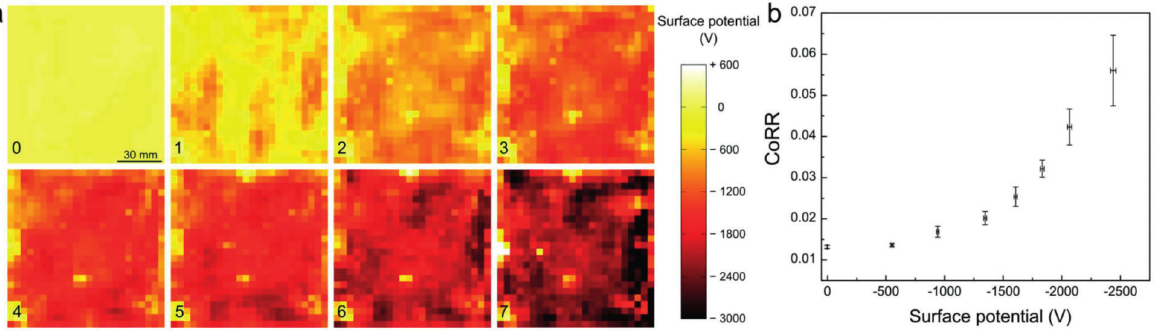
Figure 9 - ( a ) Potential maps of PTFe plates tribocharged by friction with polyethylene. ( b ) CoRR (coefficient of rolling resistance) versus average surface potential of tribocharged PTFe plates (Burgo et al.